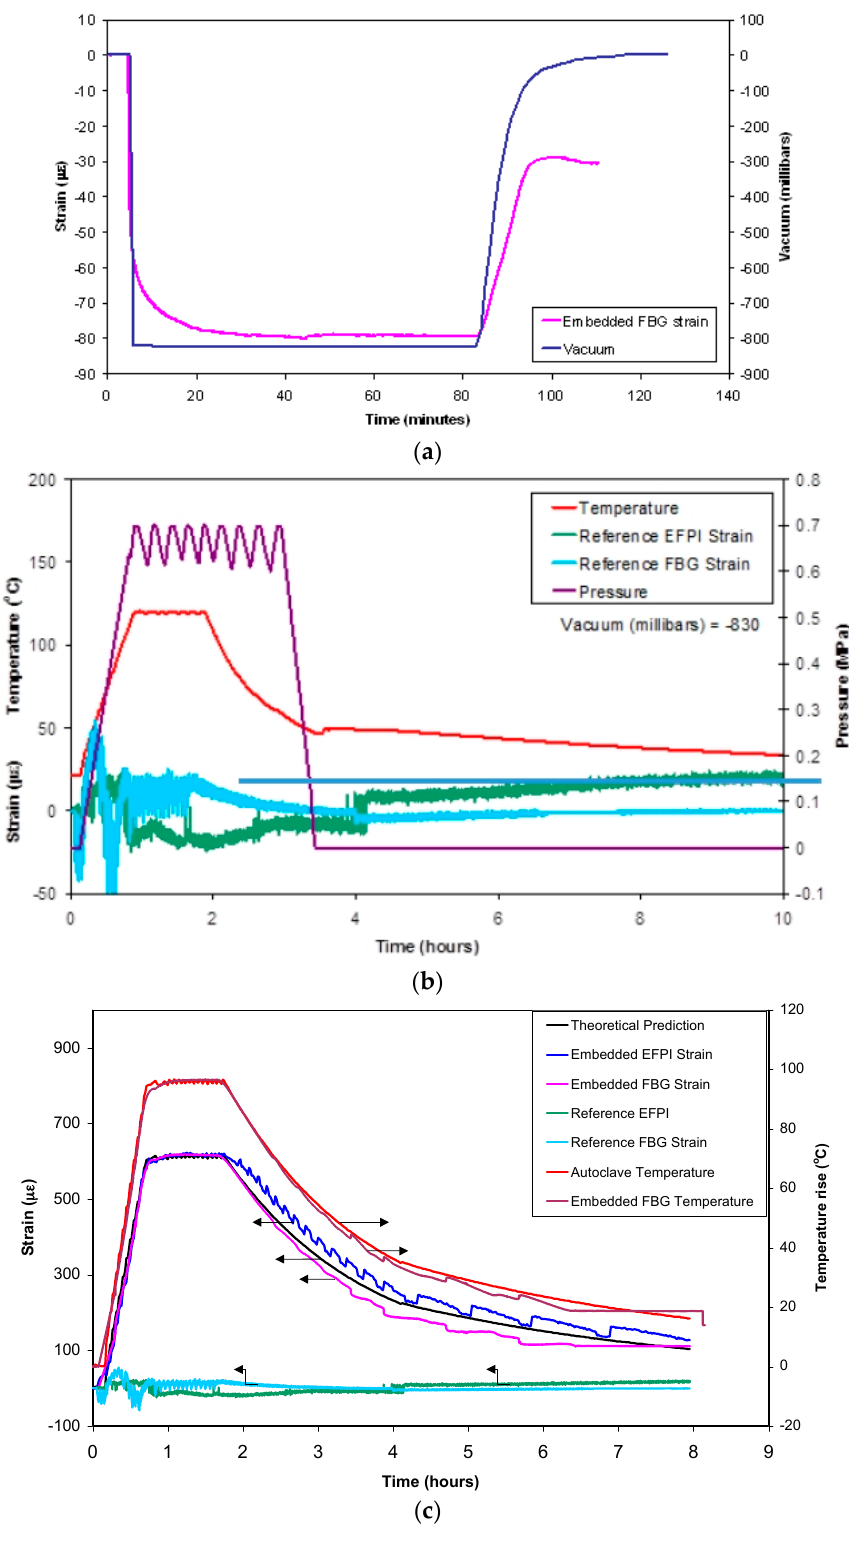
Figure 16. ( a ) The effect of the applied autoclave vacuum, via the vacuum bag, on an embedded FBG strain sensor; ( b ) Typical outputs from the surface-located reference EFPI and FBG sensors and the cure cycle parameters in the autoclave. The step in the FBG optical fibre sensor traces after approximately 4-h coincides with the time when the door of the autoclave was opened and the vacuum bag was detached.; ( c ) A comparison of the outputs from the embedded and surface-located EFPI and FBG sensors, including the data from the thermocouple, as a function of the cure schedule for a 16-ply unidirectional E-glass composite. The arrows indicate the relevant y-axis for each dataset.